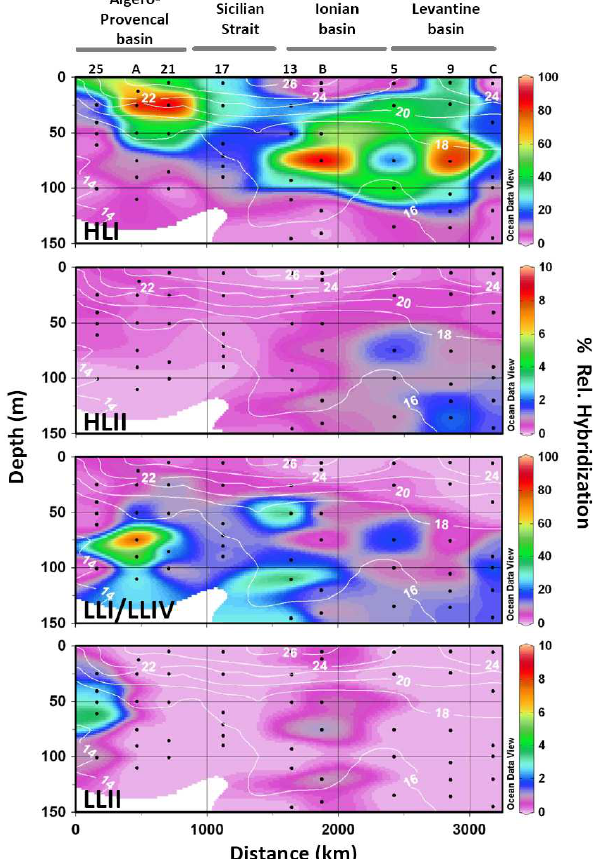
Fig. 4. Vertical distribution of Prochlorococcus ecotypes along Mella-Flores et al., Fig. 4 the BOUM cruise track analyzed by dot blot hybridization us- ing 16S rRNA gene specific oligonucleotide probes targeting HLI (high light ecotype I or eMED4), HLII (high light ecotype II or eMIT9312), LLI/LLIV (low light ecotypes I or eNATL and IV or eMIT9313) and LLII (low light ecotype II or eSS120). Contour plots indicate the % relative hybridization. The positions of the main marine regions are indicated at the top of the graph as well as the number (or letter) of the stations that have been sampled for dot blot hybridization. Details of panels are as described in Fig. 2. Note the different ranges of % relative hybridization values between